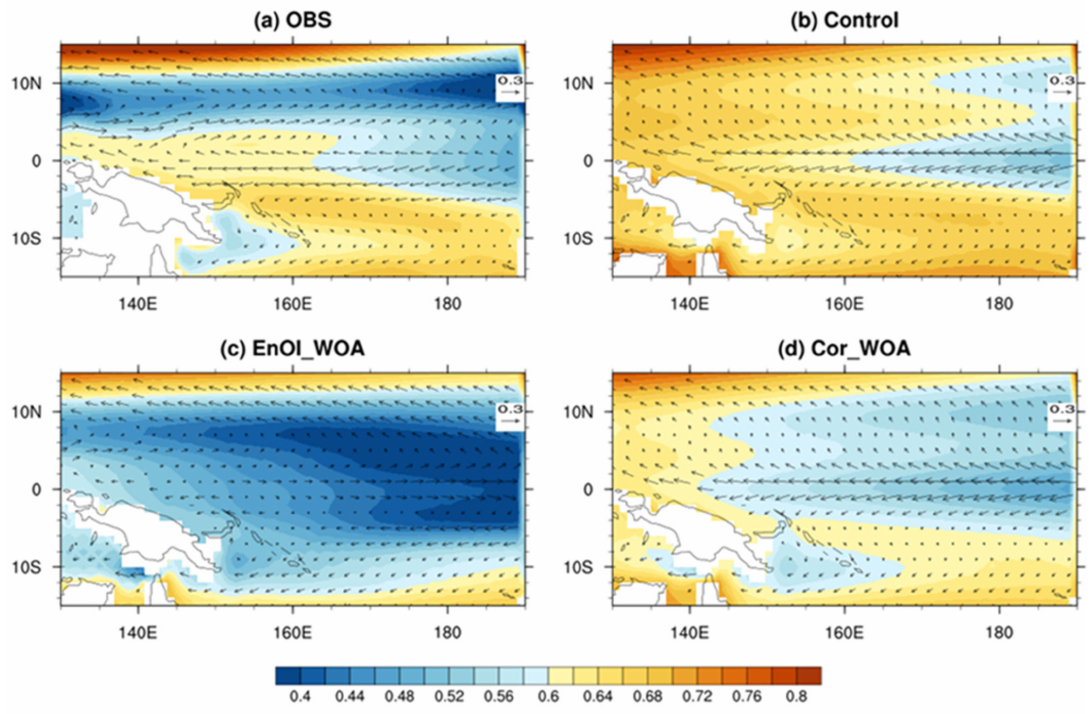
Figure 3. Long-term average horizontal distribution of the sea surface height (shaded, unit: m) and current field (arrow, unit: m/s) in the tropical western Pacific. ( a – d ) represent OBS, Control, EnOI_WOA, and